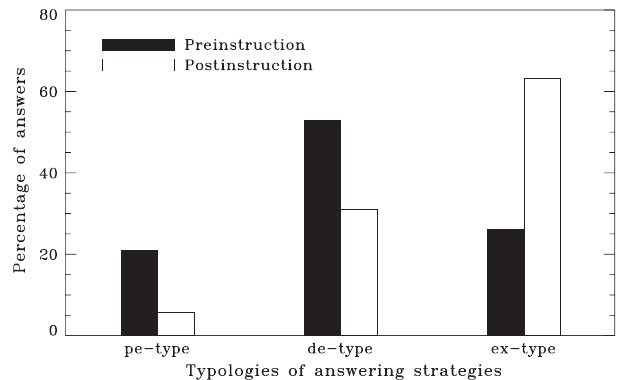
FIG. 4. Percentage of students ’ answers adopting strategies characteristic of pe-type, de-type, or ex-type profile to answer the questionnaire, administered before (black bars) and after (white bars) participating in the OI-based learning